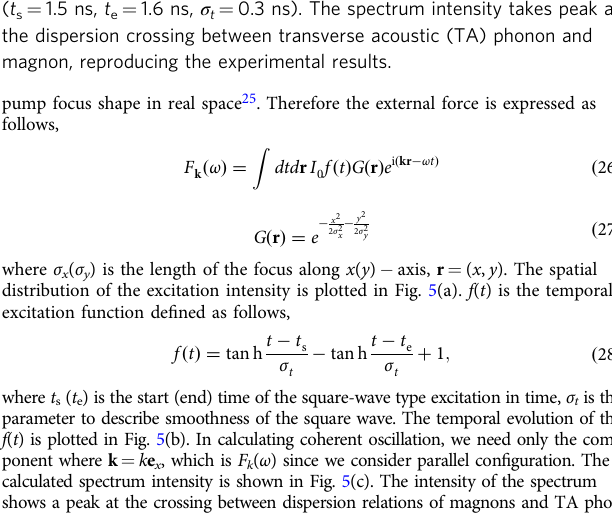
Fig. 5 Numerical calculation of magnon excitation intensity. a Heat map of G ( r ). σ x and σ y are set to realize plane-wave excitation of magnon polaron ( σ x = 40 nm, σ y = 40 nm). b Time evolution of excitation intensity